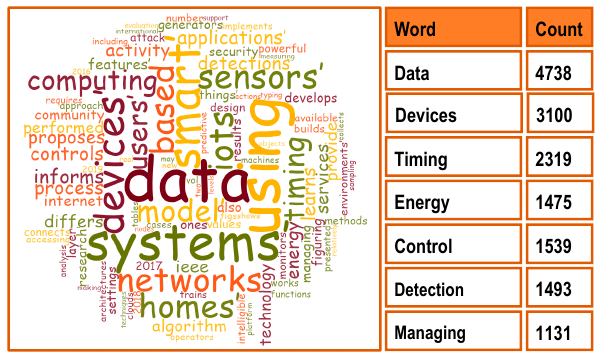
Figure 9. The word cloud based on the frequency of exact words, and the frequency of words within Group 3 of the AISH database considering word stems.